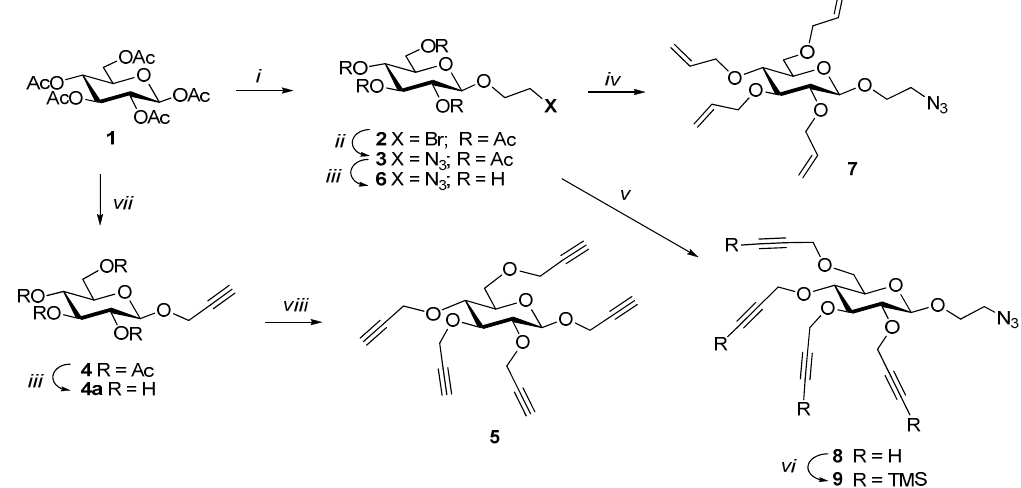
Scheme 1. Syntheses of the glyconanosynthons. Reagents and conditions : (i) 2-bromoethanol, BF 3 ·OEt 2